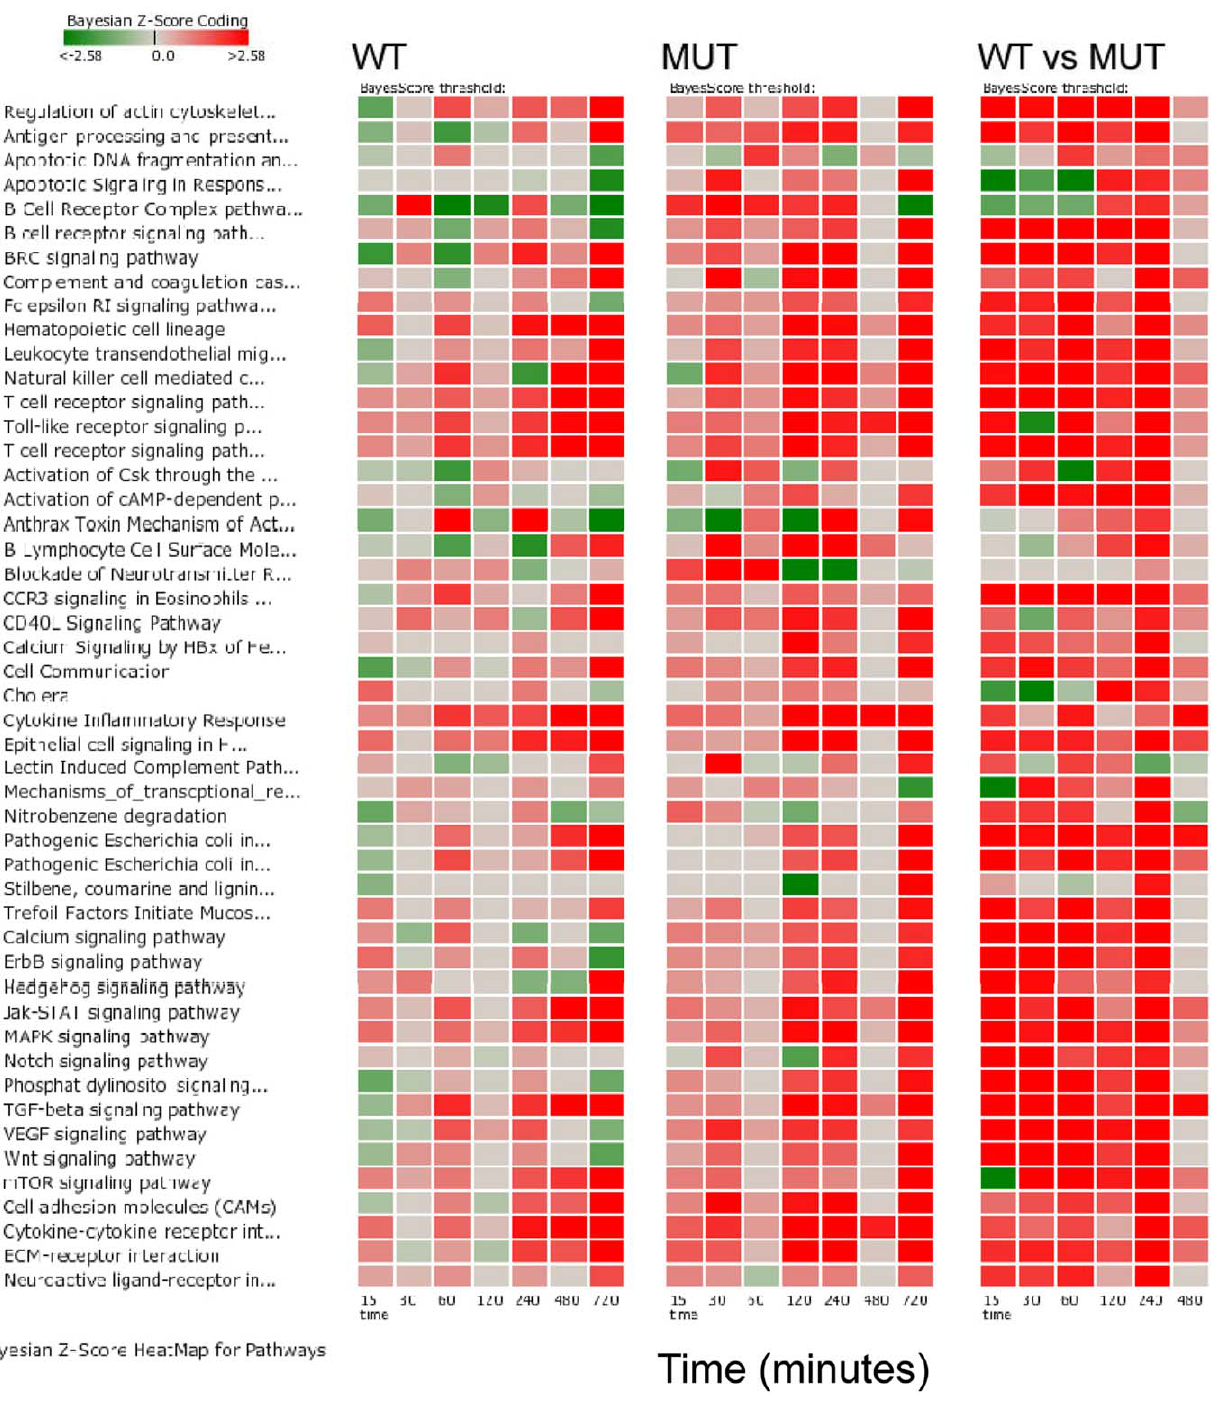
Figure 5. Pathway scores in bovine intestinal loops inoculated with wild type S.enterica serovar Typhimurium and the D sipA , sopABDE2 mutant. Heat map comparison of pathway scores for each host condition by sampling time point post infection was generated. Pathways were limited to the categories of cell mobility, cell communication, cell growth and death, infectious diseases, immune system, membrane transport, and signal transduction were compared. The score magnitudes are shown as a gradient color from light to bright red for induced and from light to bright green for suppressed pathway activity. Comparisons between wild type inoculated loops and control loops are labeled WT; between the D sipA , sopABDE2 mutant inoculated loops and control loops inoculated with LB broth are labeled MUT; and between wild type and the D sipA , sopABDE2 mutant inoculated loops are labeled WT vs. MUT.